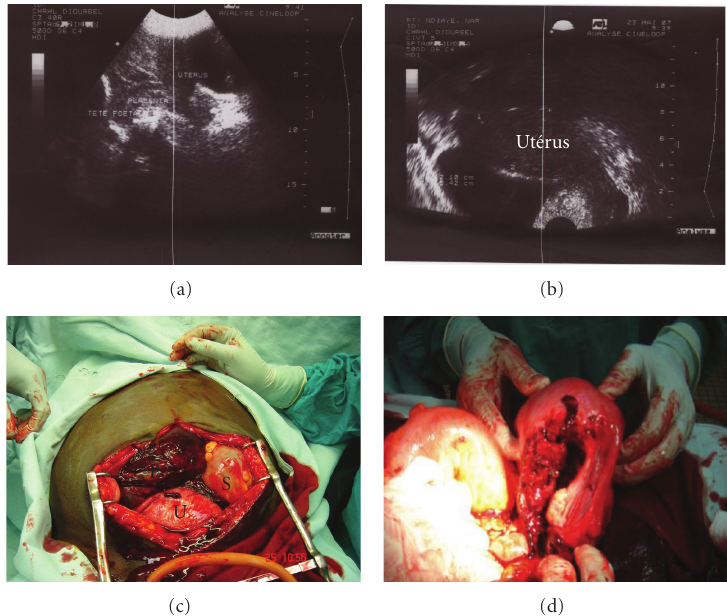
Figure 1: (a) Ultrasound image showing empty uterus, placenta, and fetal head; (b) empty uterus (extension); (c) visualization of the uterus (U), the gestational sac (S), and placenta (P) after opening the abdomen; (d) image showing uterine rupture.